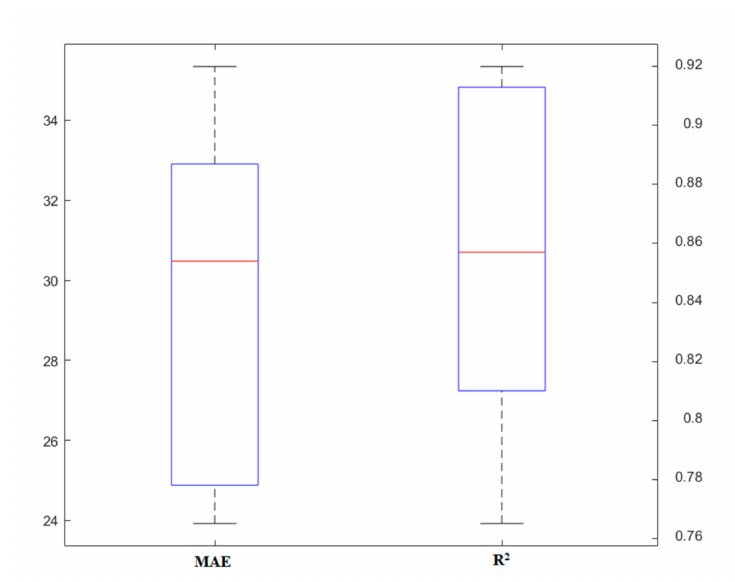
Figure 3. The results of the random forest (RF) model based on a di ff erent number of trees.